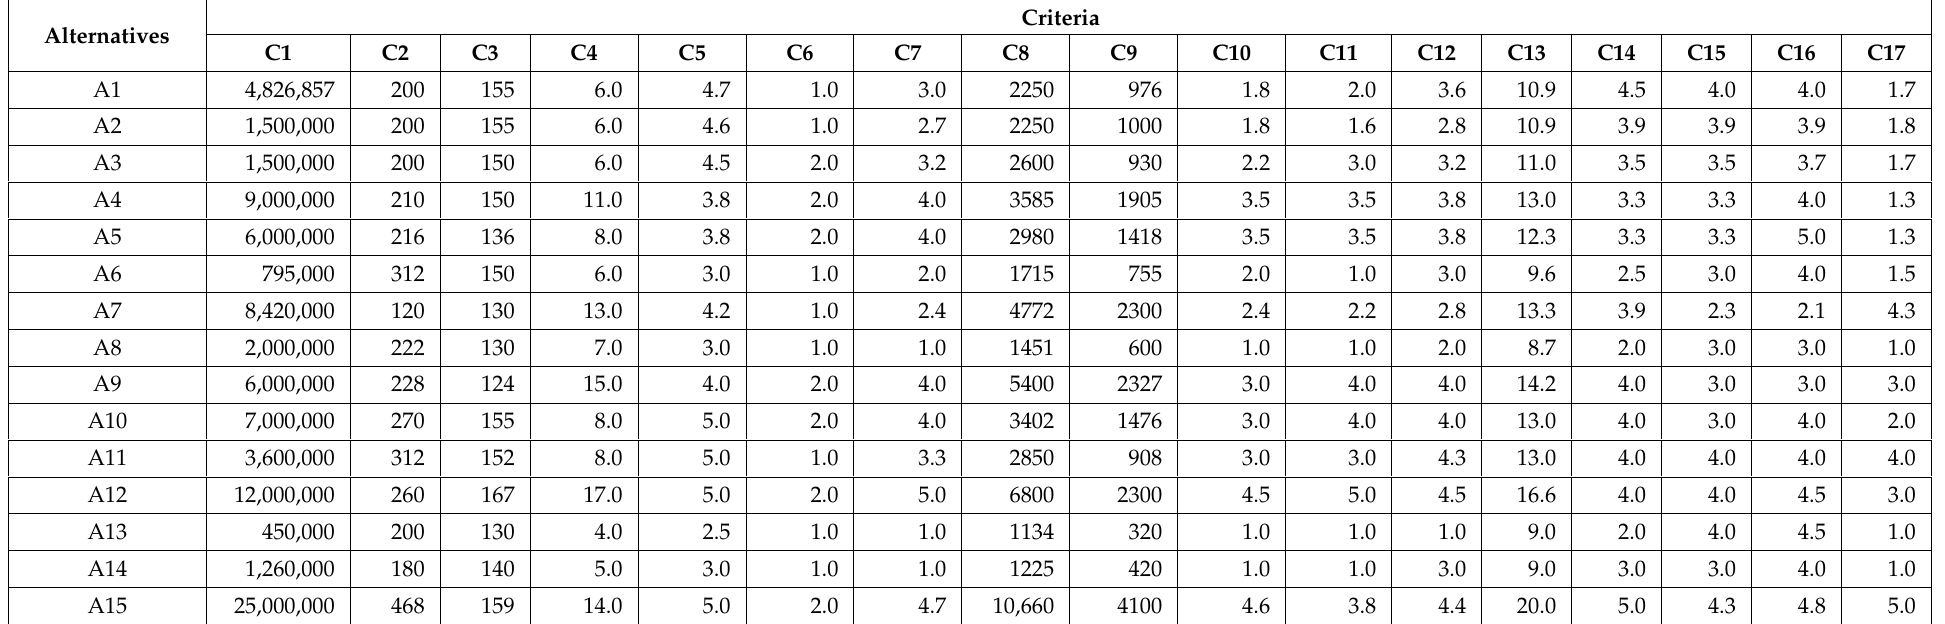
Table 2. Matrix of evaluation of the aircraft concerning the